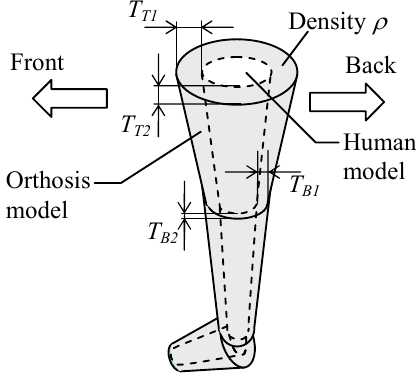
Fig. 4 Schematic figure of design parameters with respect to